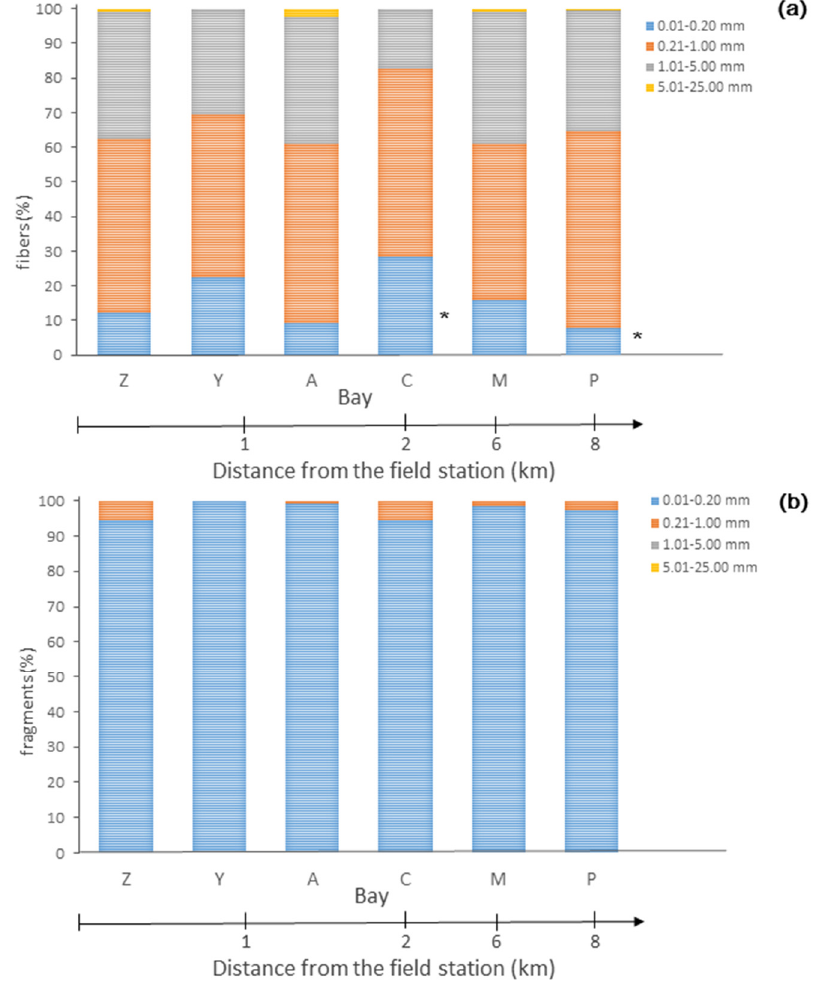
Figure 3. The percentage of microplastic ( a ) fibers and ( b ) fragments of different size classes (0.01–0.20 mm, 0.21–1.00 mm, 1.01–5.00 mm), and mesoplastic (5.01–25.00 mm) in the surface water of the studied bays of the Barents Sea: (A) Avarijnaya, (C) Plokhie Chevry, (M) Medvezhya, (P) Porchnikha, (Y) Yarnyshnaya, and (Z) Zelenetskaya. The distance (in km) from the field station is shown by the arrows at the bottom of the graphs. Statistically significant differences are indicated by * p < 0.05.